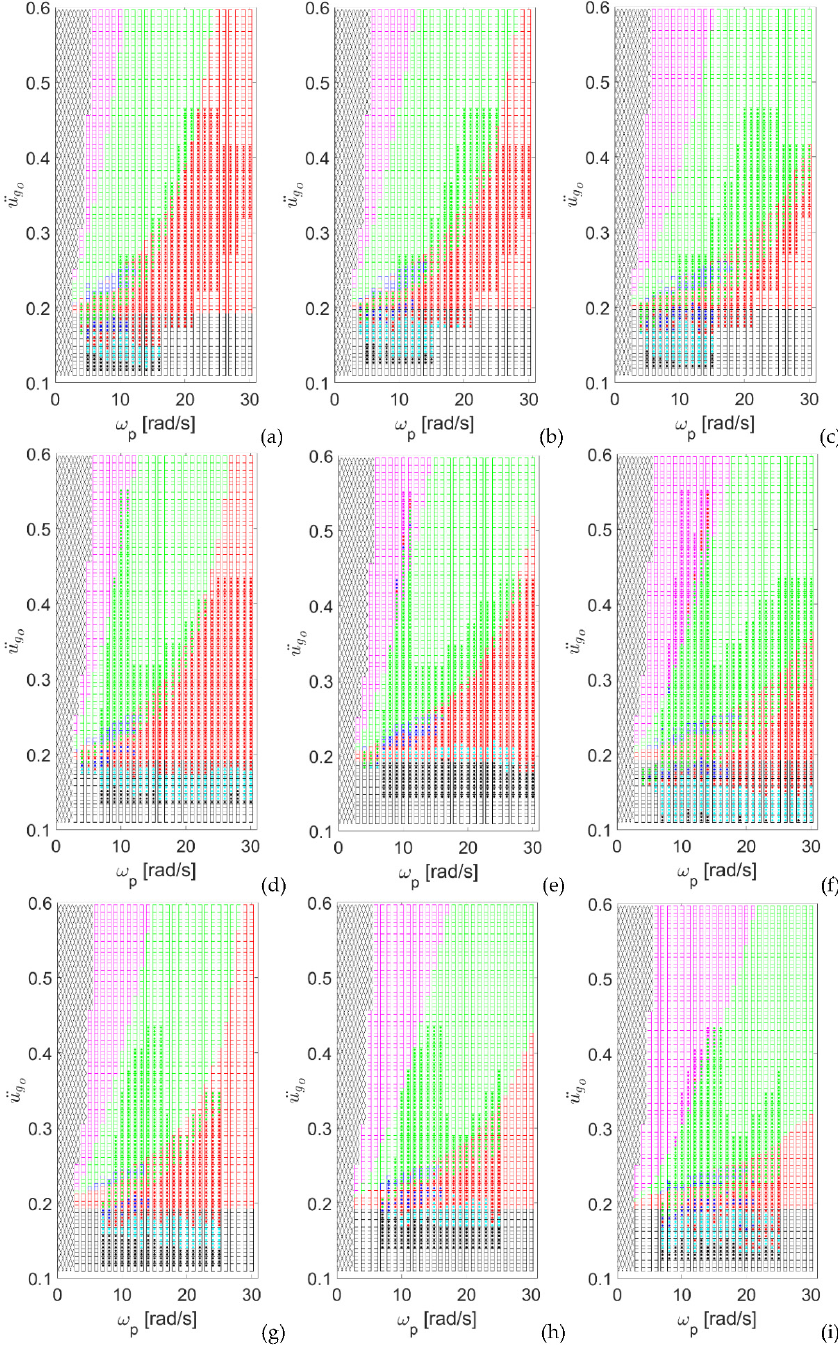
Figure 12. Stability spectra of the nine tested specimens comparing experimental results (dots) and ideal numerical model (squares): ( a ) A1, ( b ) A2, ( c ) A3, ( d ) B1, ( e ) B2, ( f ) B3, ( g ) C1, ( h ) C2, ( i ) C3.